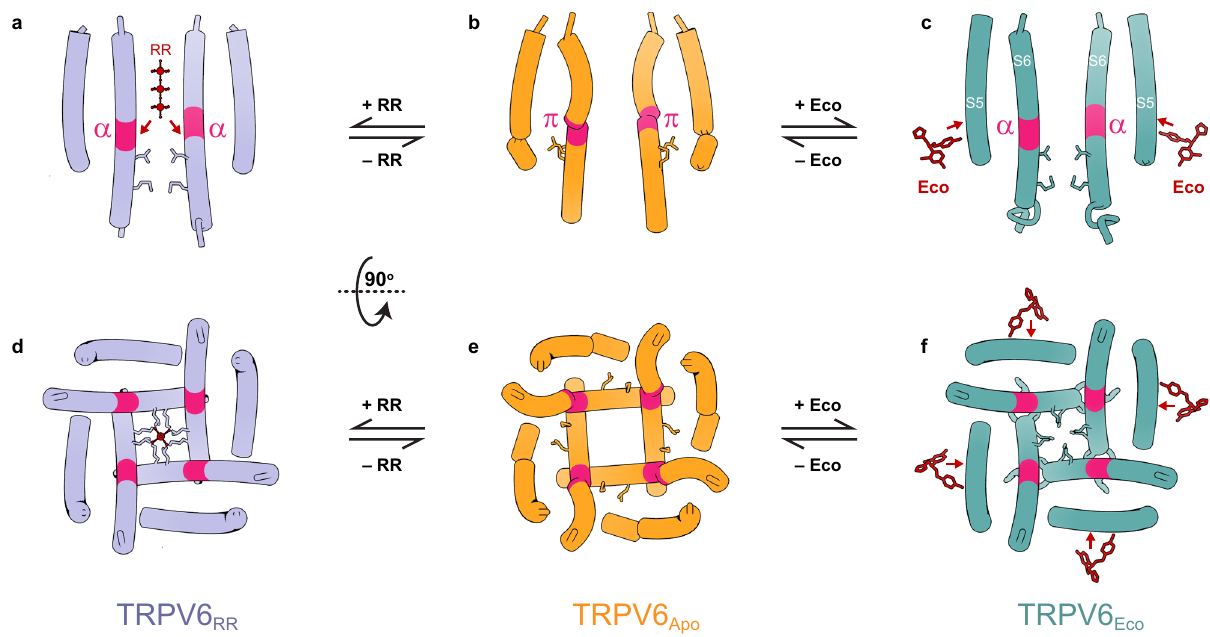
Fig. 6 Mechanisms of inhibition. Side ( a – c ) and bottom ( d – f ) views of the ion channel pore in TRPV6 RR ( a , d ), TRPV6 Open ( b , e ), and TRPV6 Eco ( c , f ). Only two of four subunits are shown in a – c , with the front and back subunits omitted for clarity. Residues that form the gate in the closed channel and molecules of RR and econazole (Eco) are shown as sticks. Arrows illustrate the directionality of force exerted by RR and econazole on S6 and S5, respectively, to close the ion